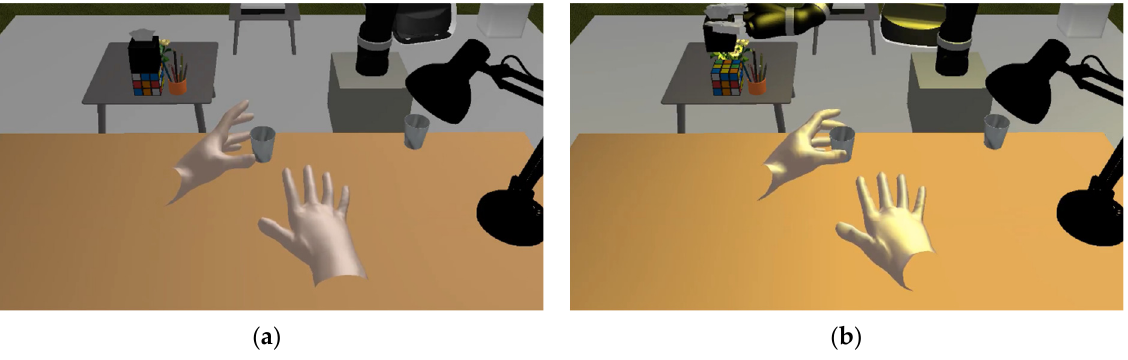
Figure 8. Execution result of the proposed scheduler: ( a ) before the user lifts the cup and ( b ) after the user raises the cup (light turns on).